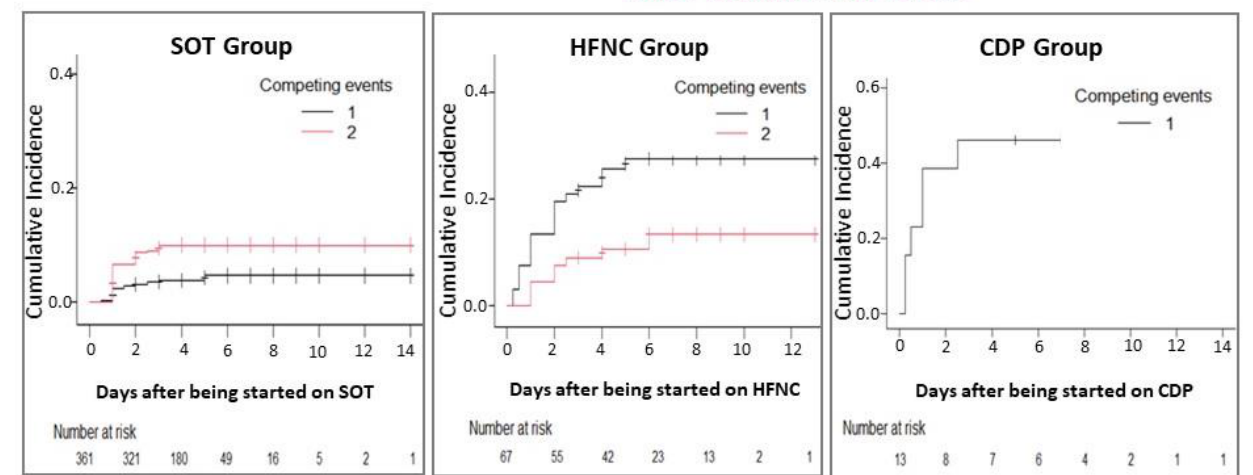
Figure 4. Survival and competing risks analysis by groups. ( A ) Survival analysis: time free from respiratory therapy escalation or ICU transfer by groups. ( B ) Competing risk analysis to determine which event (1. ICU transfer, 2. Respiratory therapy escalation) occurred first by groups: Event 1, ICU transfer; Event 2, respiratory therapy escalation.